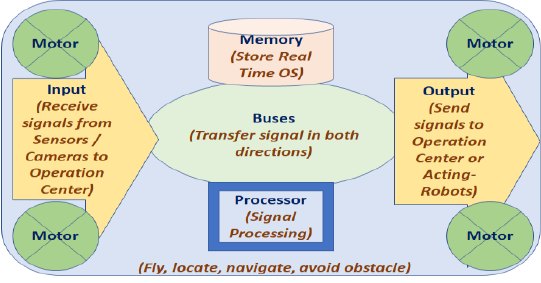
Figure 5 . The basic components of the